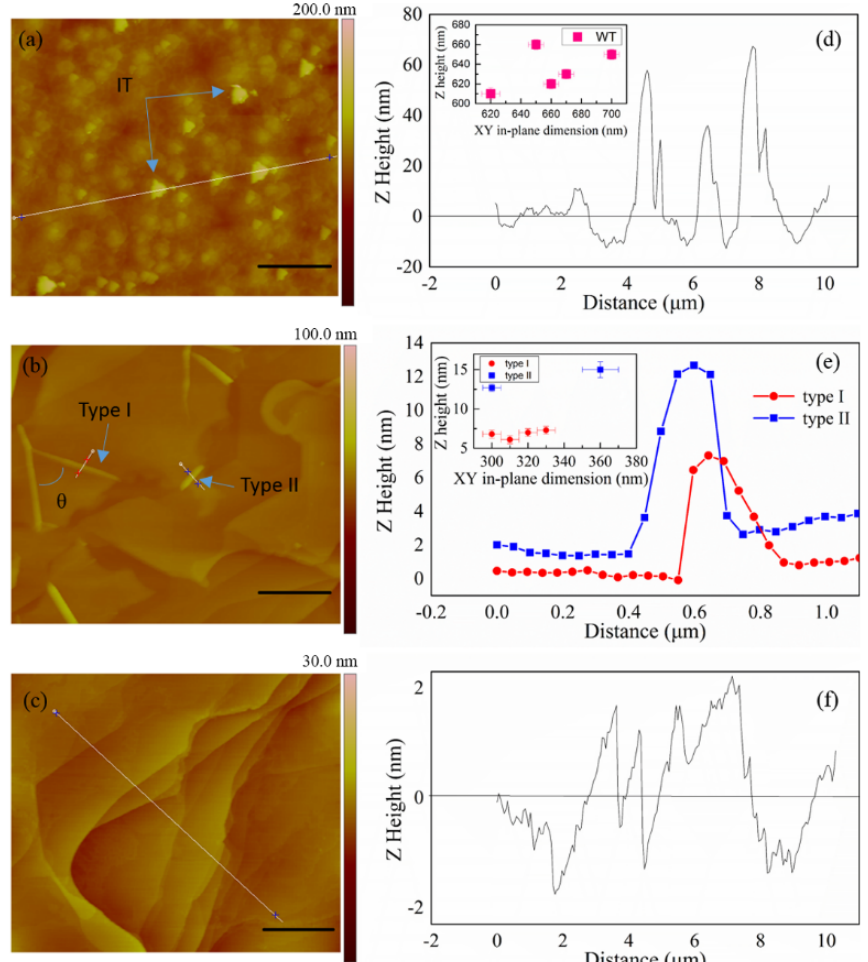
Figure 2. EG samples grown on C-faced 4H-SiC substrates. ( a ) Sample C-100-mbar; ( b ) Sample C-10-mbar; ( c ) Sample C-1-mbar; ( d ) Atomic force microscopy (AFM) line profile for the white line in ( a ). Inset: distribution of three dimensional sizes of individual terraces in ( a ); ( e ) AFM line profiles for two types of ridges in ( b ). Inset: distribution of three dimensional sizes of ridges in ( b ); ( f ) AFM line profile for the white line in ( c ). Scale bars: 2 μ m.